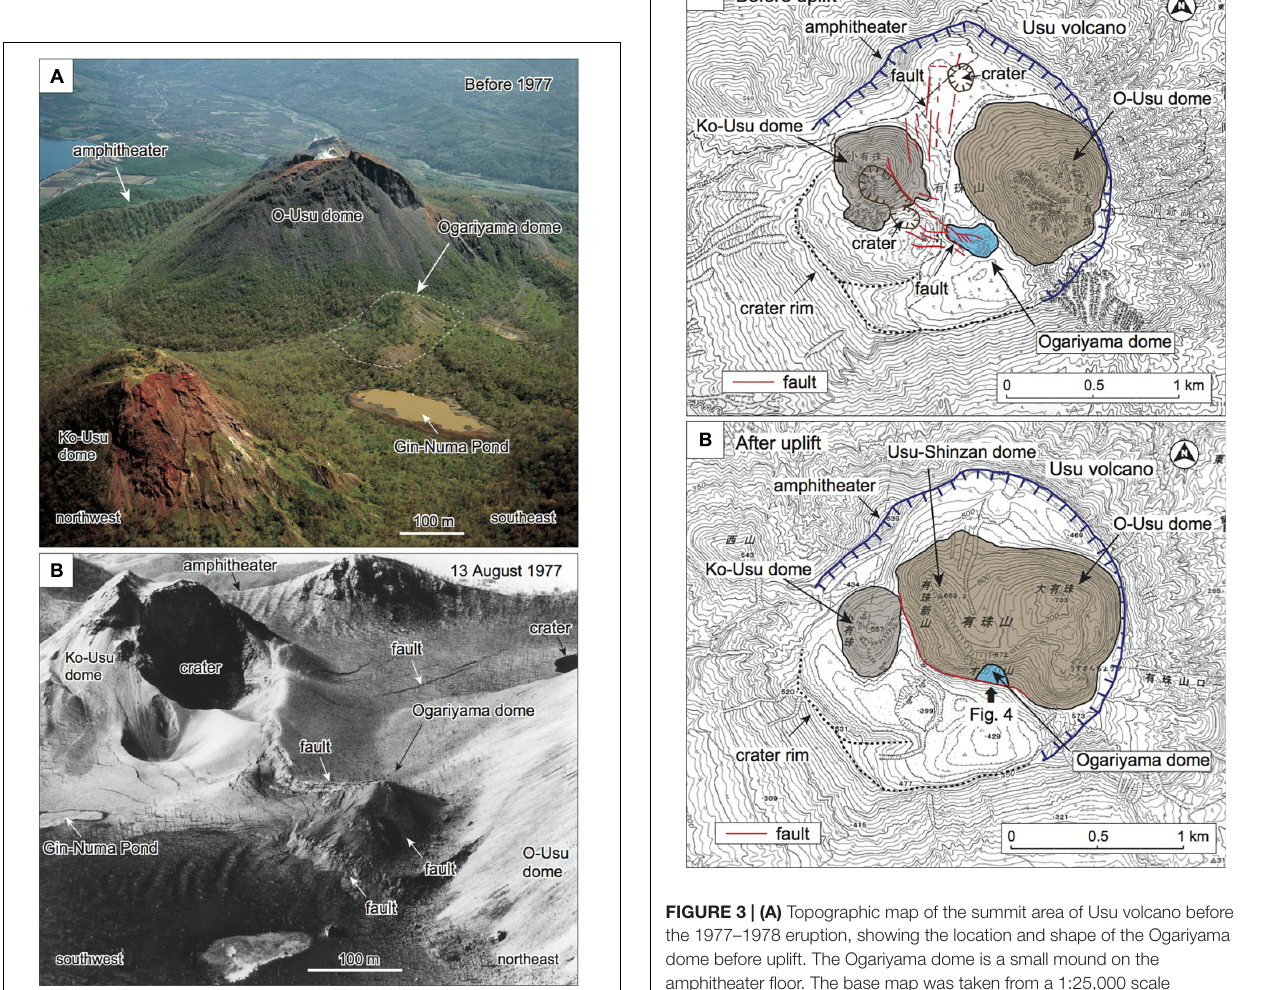
Frontiers in Earth Science |